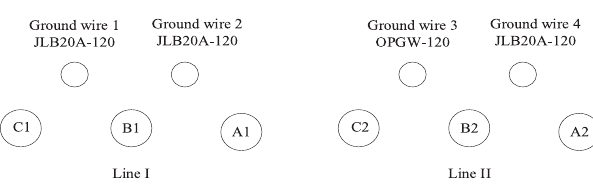
Fig. 4. The arrangement of conducting wires and ground wires of the research line (looking from the YD side to the TS